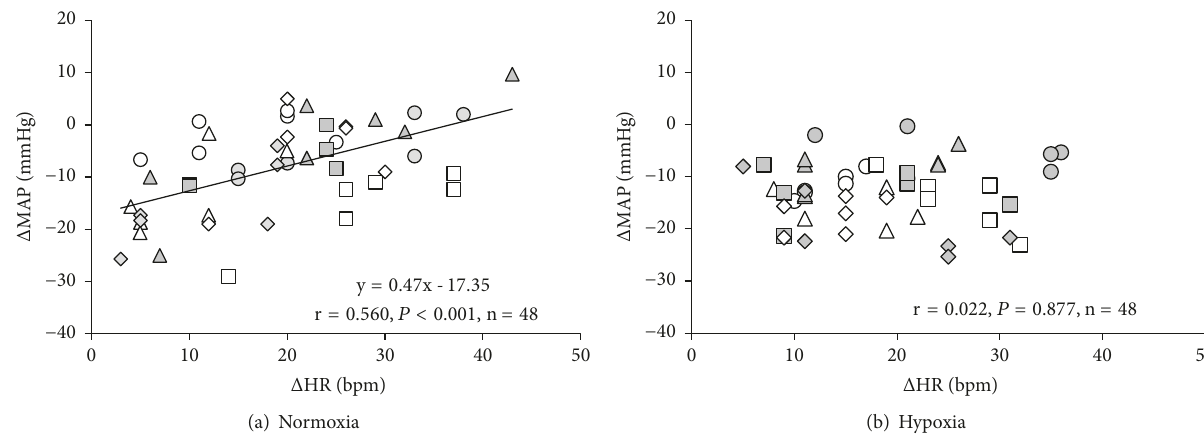
y = 0.47 x -17.35 r = 0.560,P < 0.001, n = 48